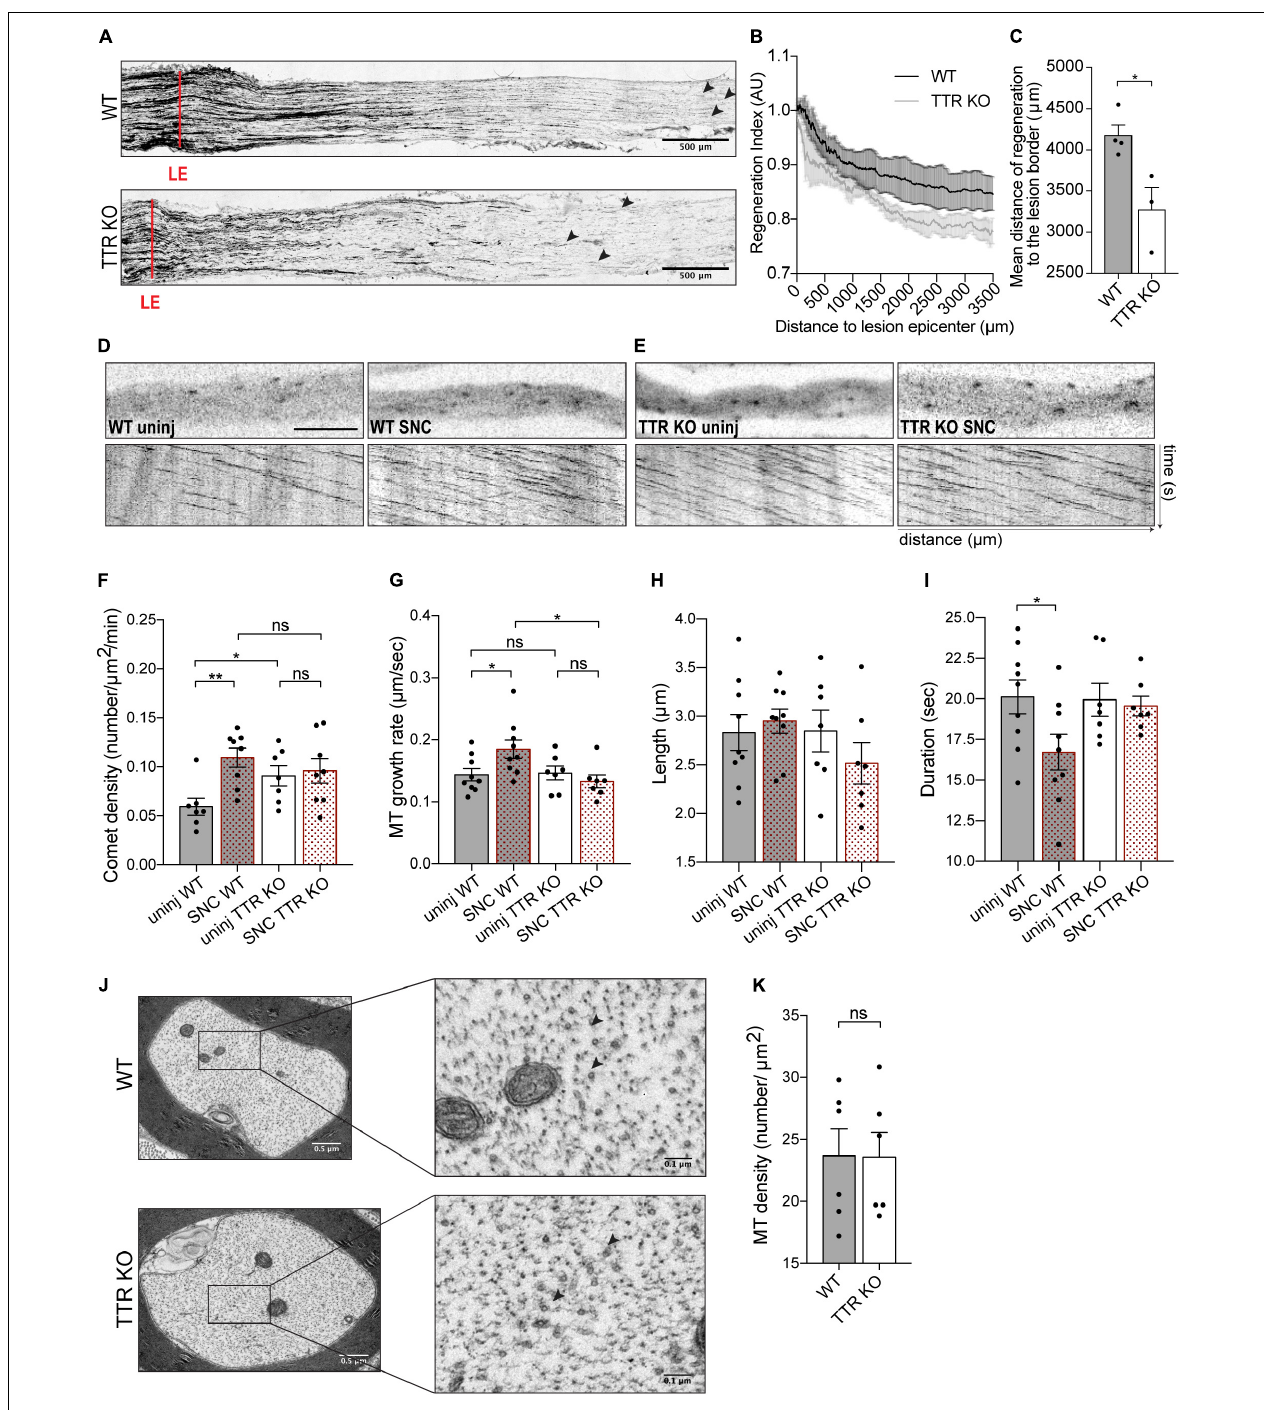
FIGURE 2 | Sciatic nerve axons from TTR KO mice have higher dynamic MT density but fail to increase MT dynamics and to regenerate their axons in response to sciatic nerve crush. (A) SCG-10 staining of longitudinal sciatic nerve sections from WT and TTR KO mice at 3 days postinjury; red lines indicate the lesion epicenter (LE), arrowheads highlight the longest regenerating axons. Scale bars: 500 µ m. (B) Regeneration index vs. distance to LE. (C) Mean distance of SCG-10 + sciatic nerve axons regenerating distally to the lesion edge. Data represent mean ± SEM ( n = 4 animals/genotype). * P < 0.05 by Student’s t -test. (D) Representative still images of the axonal shaft from a WT-Thy1-EB3-YFP uninjured nerve (WT uninj) with correspondent kymograph and of an axonal region distal to the lesion site from a WT-Thy1-EB3-YFP crushed nerve (WT SNC) with correspondent kymograph. Scale bar: 5 µ m. (E) Representative still images of the axonal shaft from a TTR KO-Thy1-EB3-YFP uninjured nerve (TTR KO uninj) with correspondent kymograph and of an axonal region distal to the lesion site from a TTR KO-Thy1-EB3-YFP crushed nerve (TTR KO SNC) with correspondent kymograph. (F–I) Quantifications of MT dynamics parameters including EB3 comet density (F) , MT growth rate